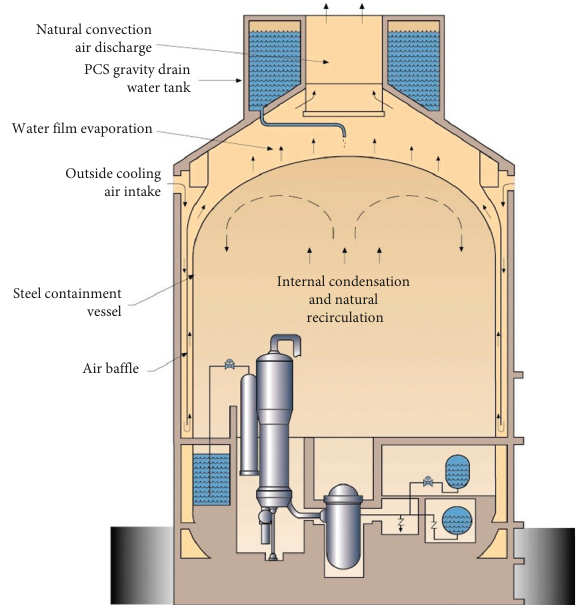
Figure 1: Shield building and PCS of AP1000 nuclear island building